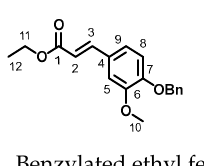
Figure 1. Benzylated ethyl ferulate.